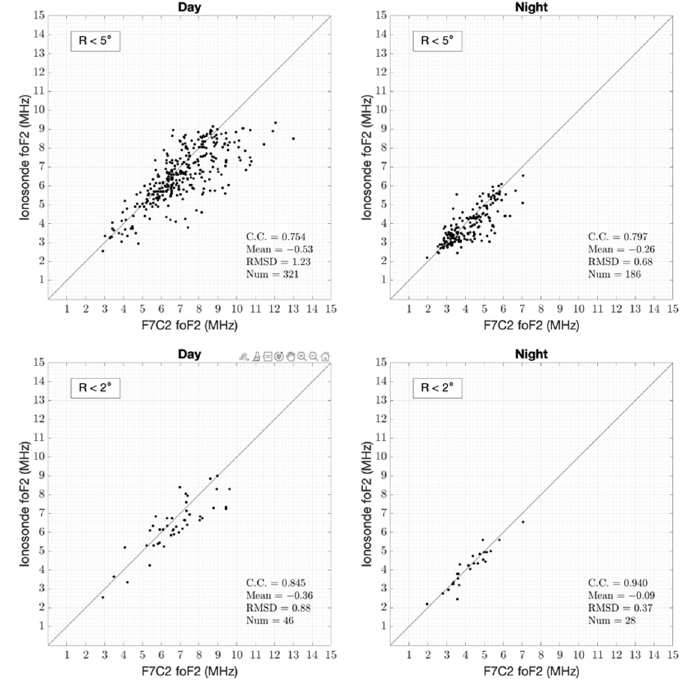
Figure 14. Daytime ( left ) and nighttime ( right ) scatter plots of the ionosonde foF2 versus F7C2 foF2 for radii of 5° ( upper ) and 2° ( lower ) for spatial coverage. Table 2. Comparison of c.c., RMSD and mean difference ( d ) for foF2.